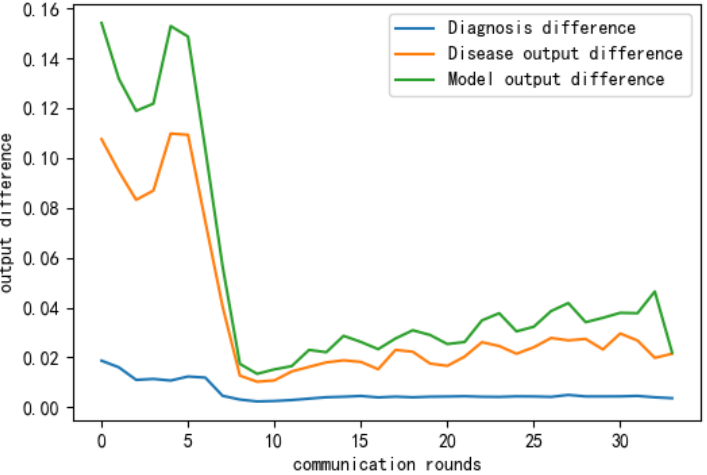
Figure 16. The output